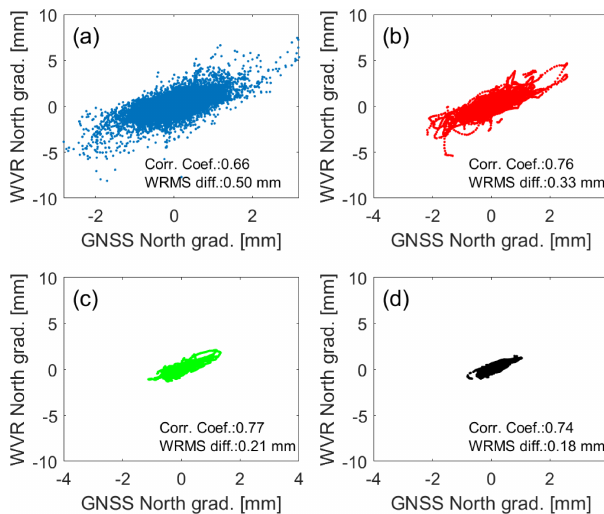
Figure 10. Correlations between estimated north gradients from the GNSS, given by the GRE solution with a 3 ◦ elevation cutoff an- gle, and the WVR data. Four different values of (cid:49)t eff are used: (a) 5min, (b) 2h, (c) 12h, and (d) 24h.